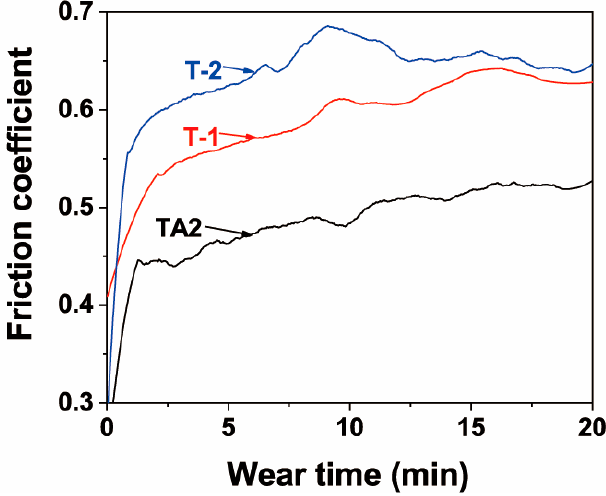
Figure 11. Friction coefficient curves of TA2, and T ‐ 1 and T ‐ 2 samples after MAO.